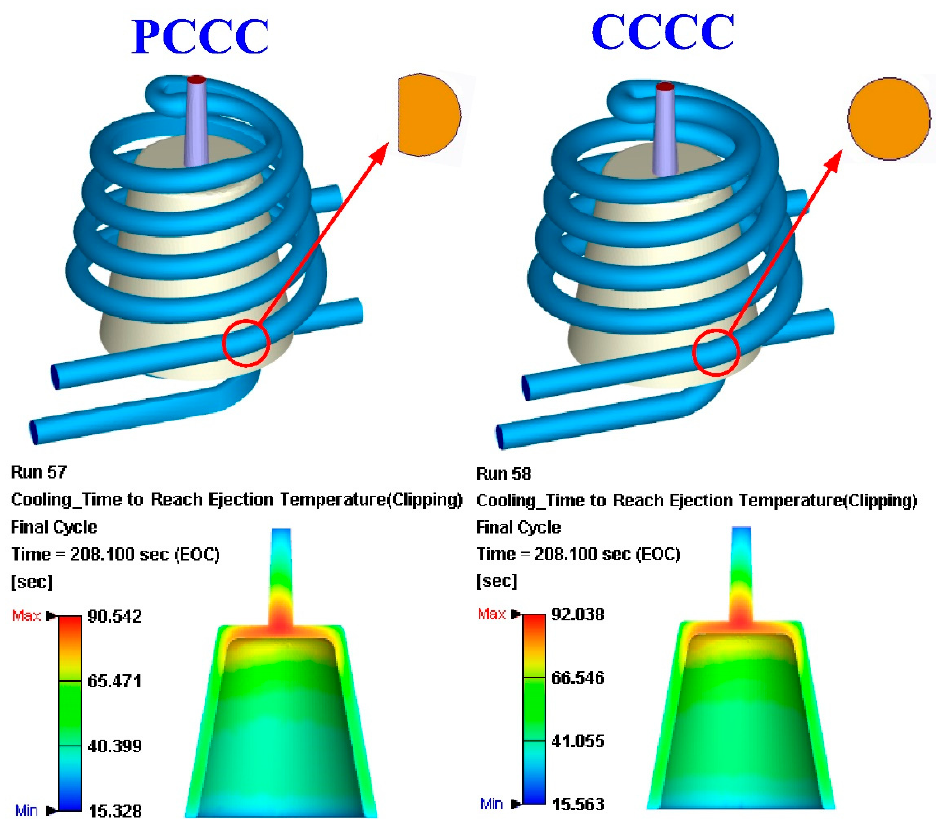
Figure 14. Simulation results of the temperature difference of the injection-molded part of the injec- tion mold fabricated by epoxy resin added with 39 vol.% Al powder. injection mold fabricated by epoxy resin added with 39 vol.% Al